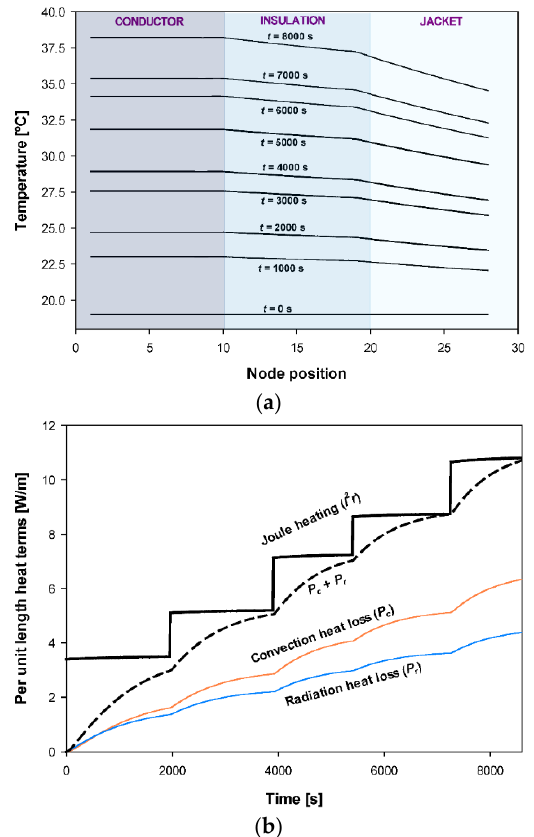
Figure 10. Conductor of 70 mm 2 : ( a ) Temporal evolution of the temperature along the radial axis considering 28 nodal elements. ( b ) Temporal evolution of the components of the heat balance equation.